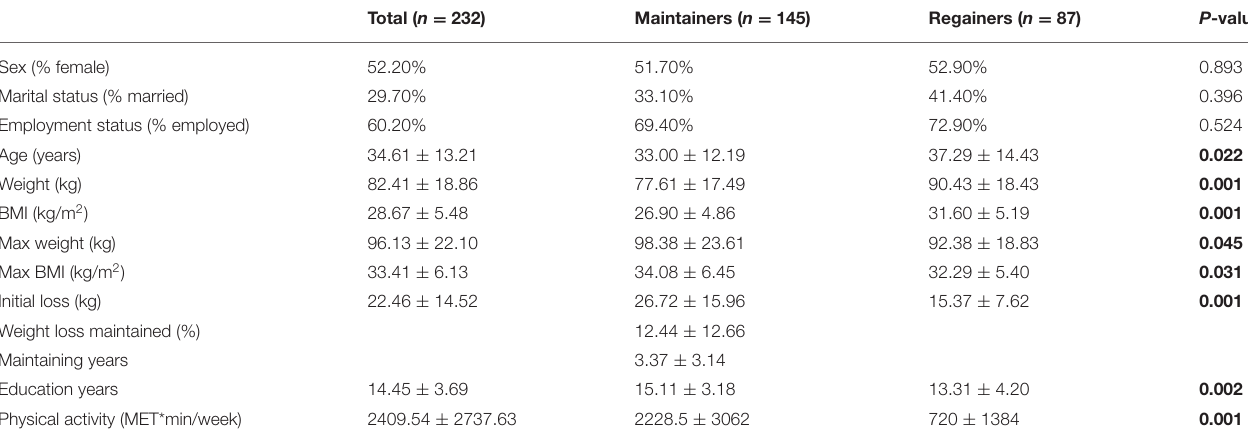
TABLE 1 | Participants’ characteristics.